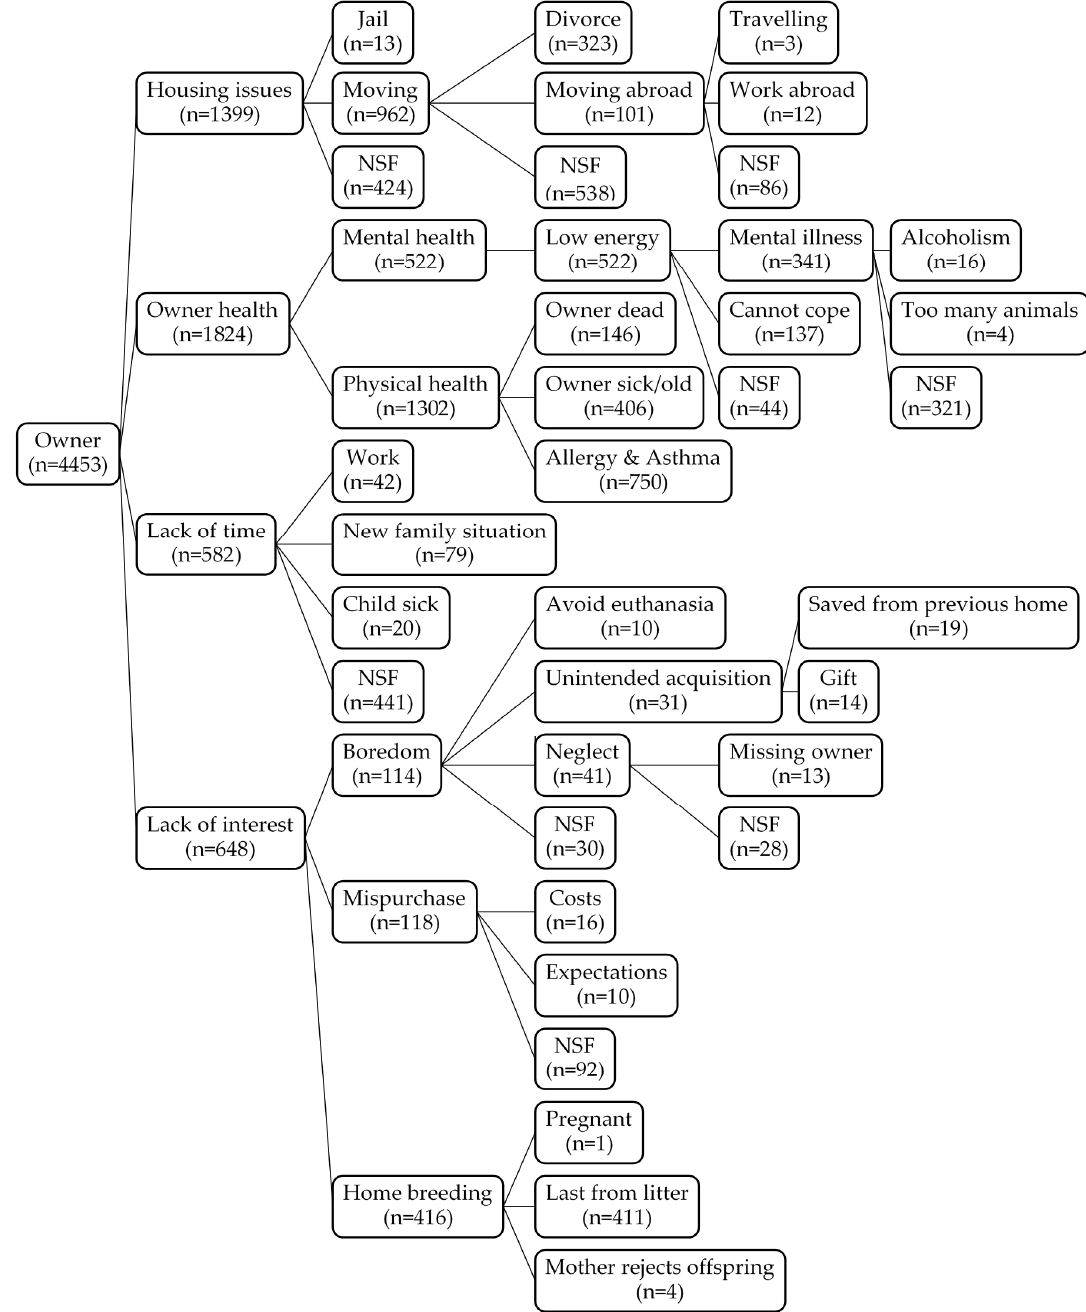
Figure 2. Reasons for relinquishment related to the owner from 1996 to 2017. Illustration of the merging and characterisation of owner-related reasons for relinquishment of dogs and cats. NSF: not specified further.